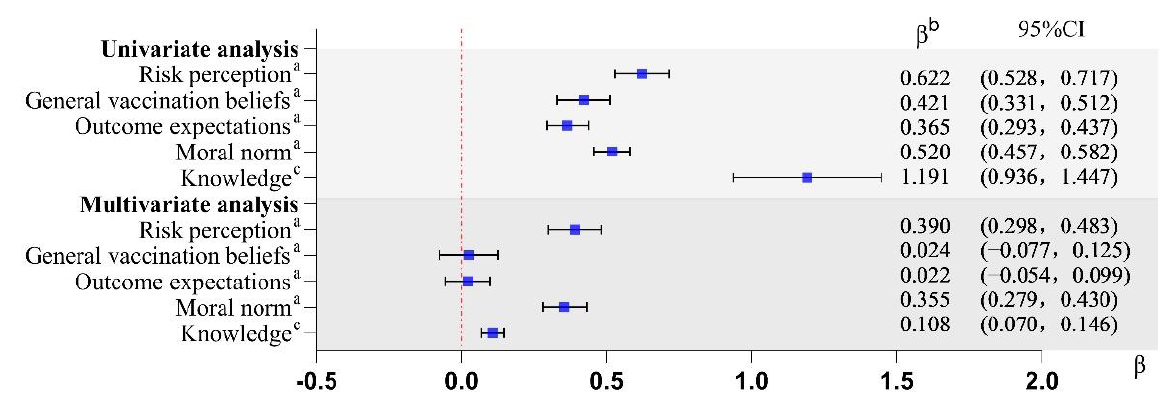
Figure 5. Univariate and multivariate linear regression analysis of the determinants of guardians’ attitude on pertussis cocooning vaccination. Note: CI = confidence interval. a Measured on a five- point Likert scale; low-high. b For each point increase on the Likert scale of the determinant, the intention changes with the value of β . c One point was awarded for each correct answer. R 2 = 35%.